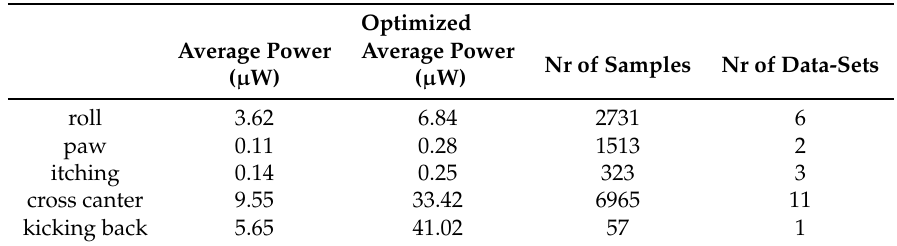
Figure 12. The average (line) of the longeing (blue) datasets is remarkably higher than the average of the riding red datasets in canter gait, although no clustering or clear separation can be seen for both techniques. The longeing datasets clearly have more energetic “other” movements. Table 6. Different movements will generate different amounts of power with an energy harvester. Kicking backwards can generate a high average power but this movement is rarely performed by the